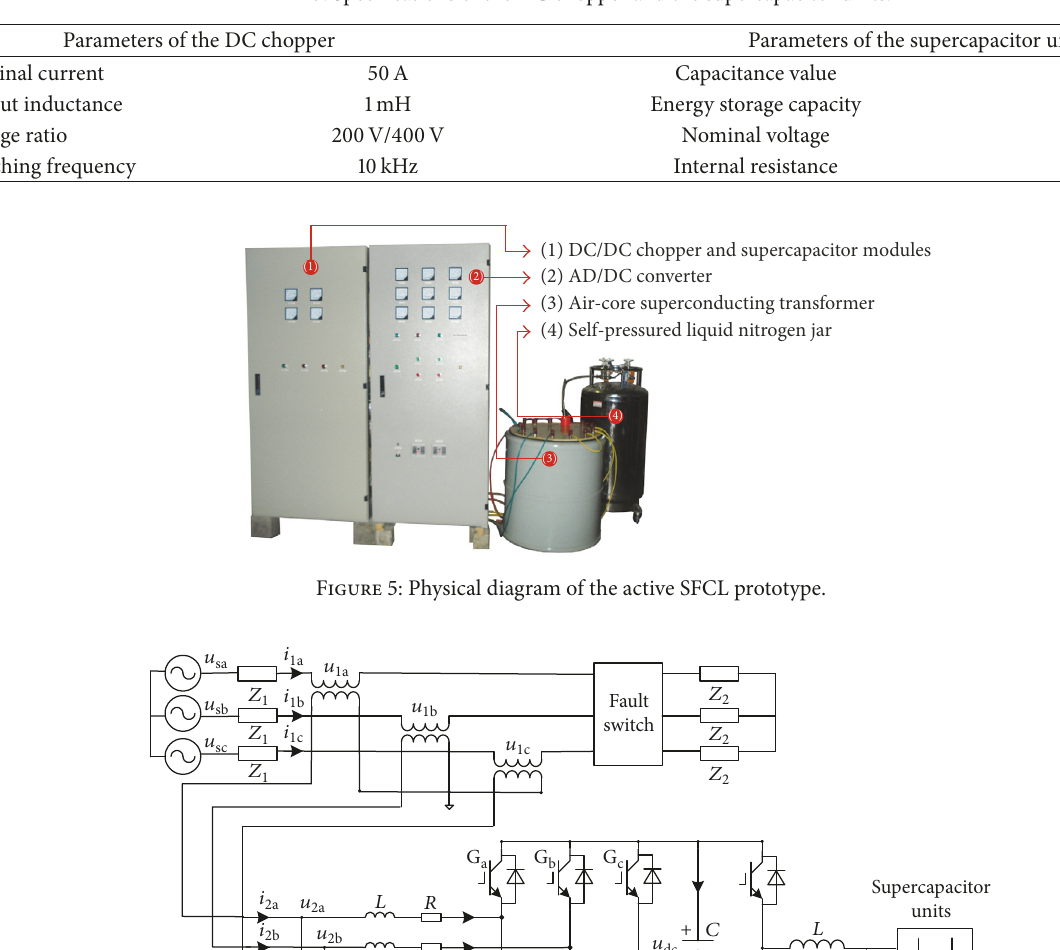
Table 3: Specifications of the DC chopper and the supercapacitor units.